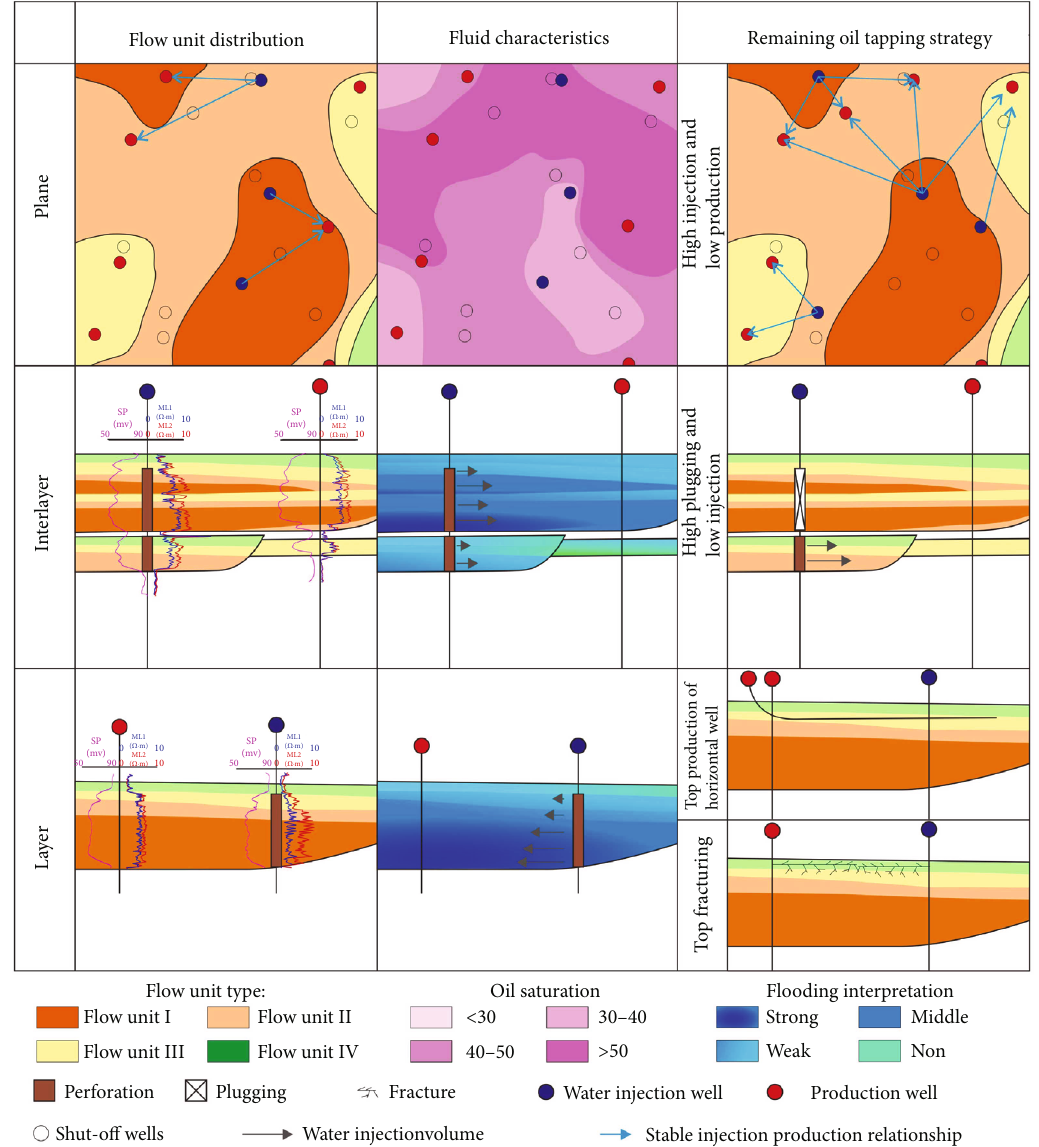
Figure 16: Di ff erent types of remaining oil and their potential tapping